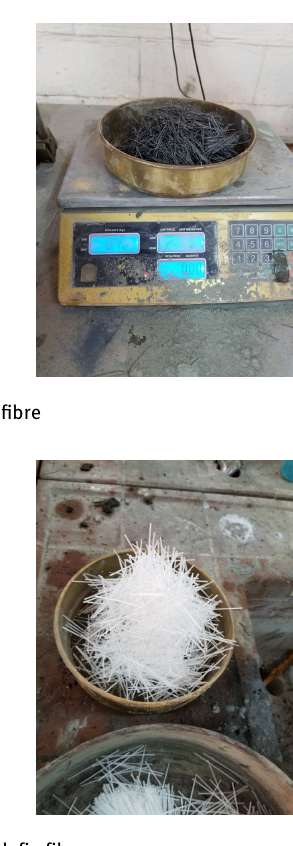
Figure 2: Polyolefin fibre